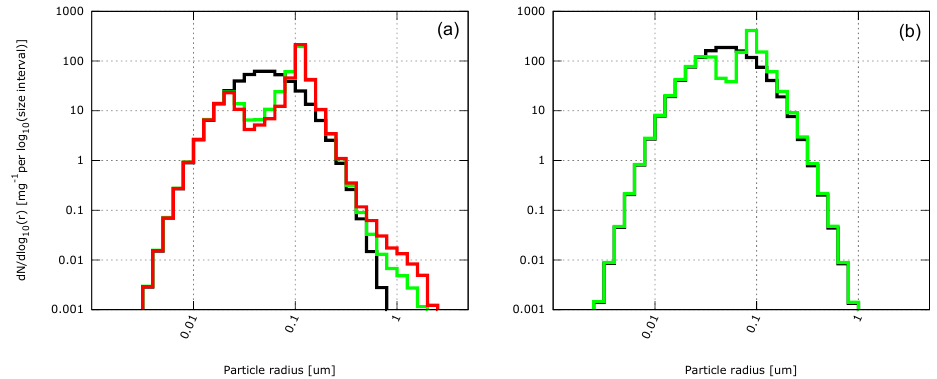
Figure 6. The size distributions of dry radii for the base case (a) and case3 (b) . The initial dry radius size distribution is marked in black, the final dry radius size distribution from grid cells with r c > 0 . 01gkg − 1 in green, and from grid cells with r r > 0 . 01gkg − 1 in red. See Tables 2 and 3 for a definition of simulation